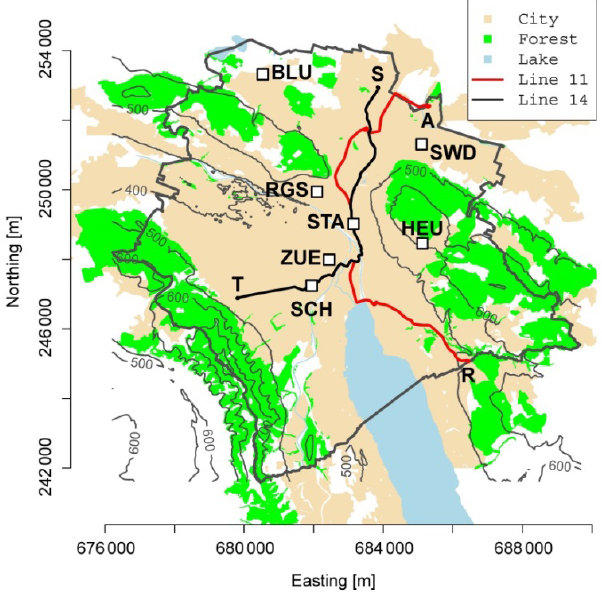
Figure 3. Map showing the city of Zurich. The tram line no. 11 from Rehalp (R) to Auzelg (A) is depicted by a red line, the tram line no. 14 from Triemli (T) to Seebach (S) is depicted by a black line. The white squares depict the air quality monitoring sites op- erated in Zurich. Light grey lines are contour lines indicating the elevation of Zurich and the municipal boarder is shown in dark